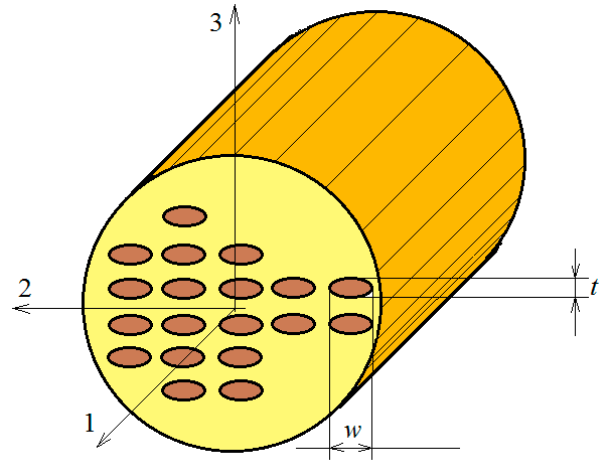
Figure 1. Reinforced composite with aligned elliptic